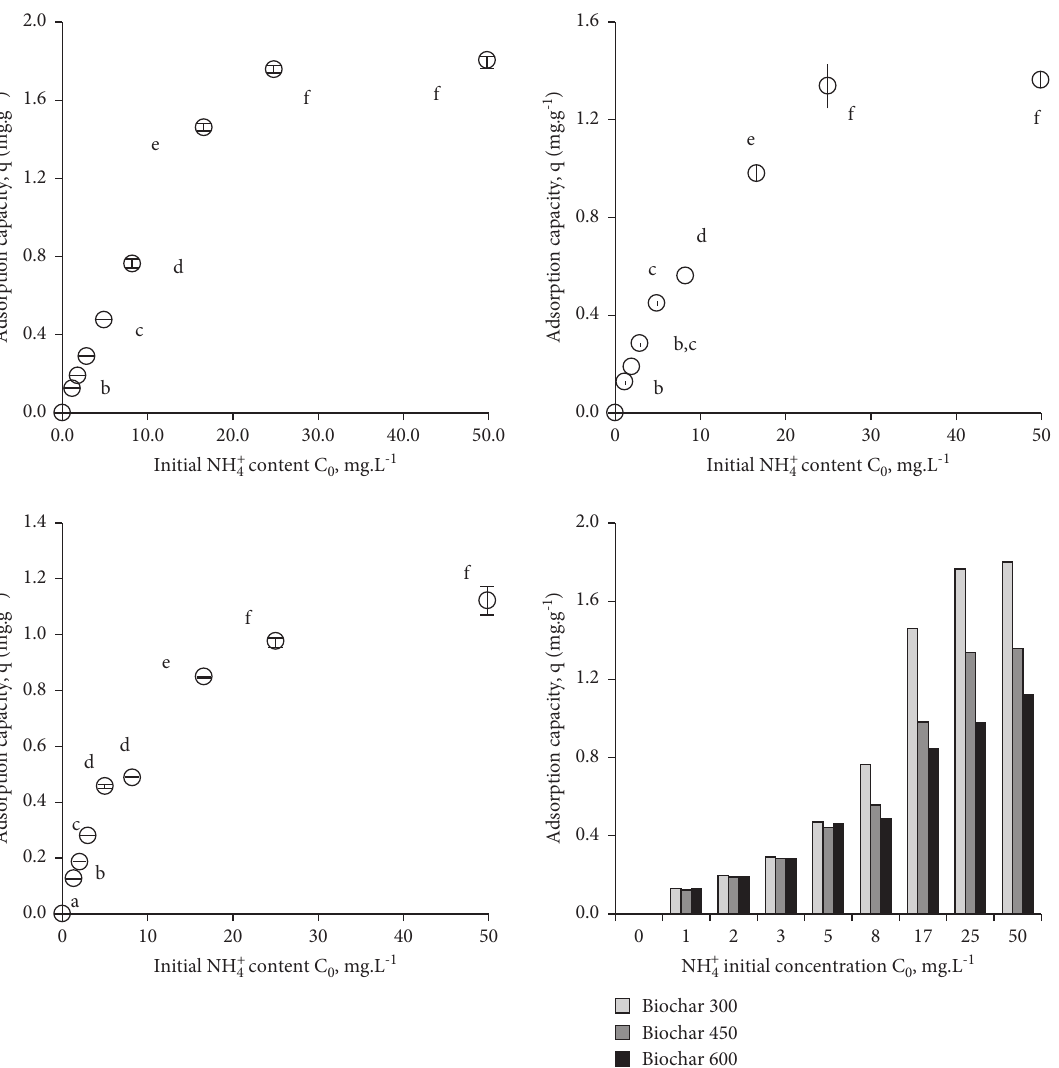
Figure 2: Adsorption capacity NH + (mg · g − 1 ) vs .Co (mg · L − 1 ) at different pyrolytic temperatures. Different letters represent statistically 4 significant differences. (a) Biochar at 300 ° C, (b) biochar at 450 ° C, (c) biochar at 600 ° C, and (d) adsorption efficiency of 3 forms of biochar.